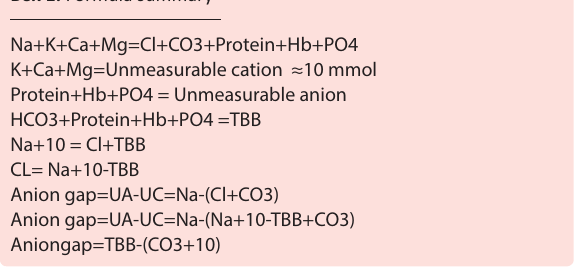
Figure 1. Blad-Altman plot showing agreement between calculated and measured serum chloride levels